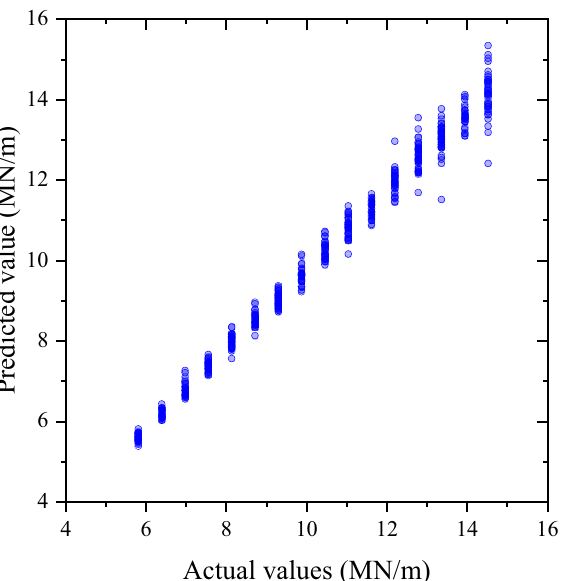
Figure 5. Actual data and prediction.